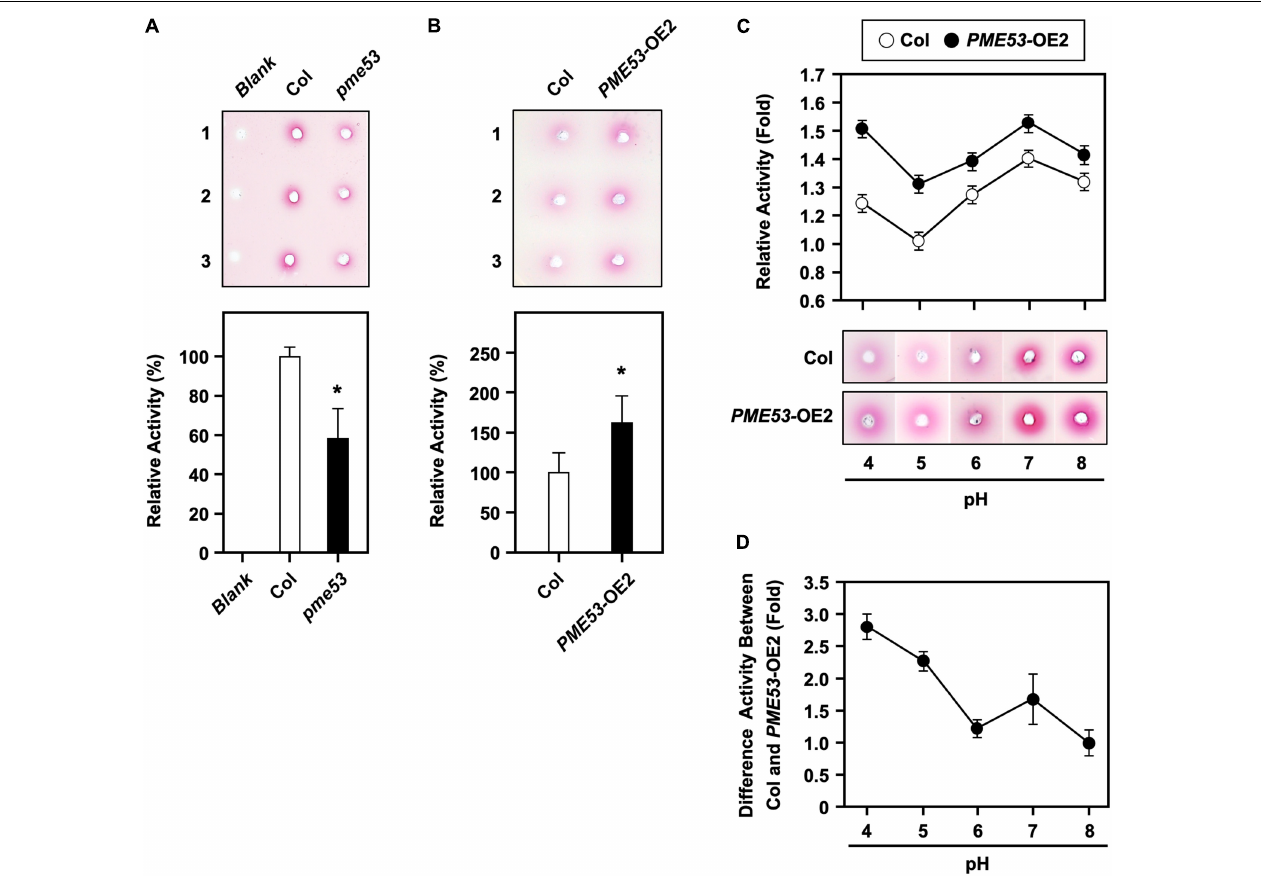
FIGURE 3 | PME activity assay in pme53 mutant and PME53 -overexpression plants. PME activity was analyzed (A) in Col and pme53 and (B) in Col and PME53- OE2 plants. The ruthenium red-stained zone diameters resulting from the hydrolysis of esterified pectin in an agarose gel by diffusion were photographed and measured. The fold change PME activity was normalized relative to level of the Col. Data are mean ± SE of three biological replicates. *Significant at P < 0.05 compared with the Col. Blank, the buffer used only. (C) PME activity analyzed at pH levels of 4 to 8. PME activity was normalized to the weakest activity at pH 5 of the Col. (D) The optimal PME53 activity at different pH levels was summarized. Data are mean ± SE of three biological